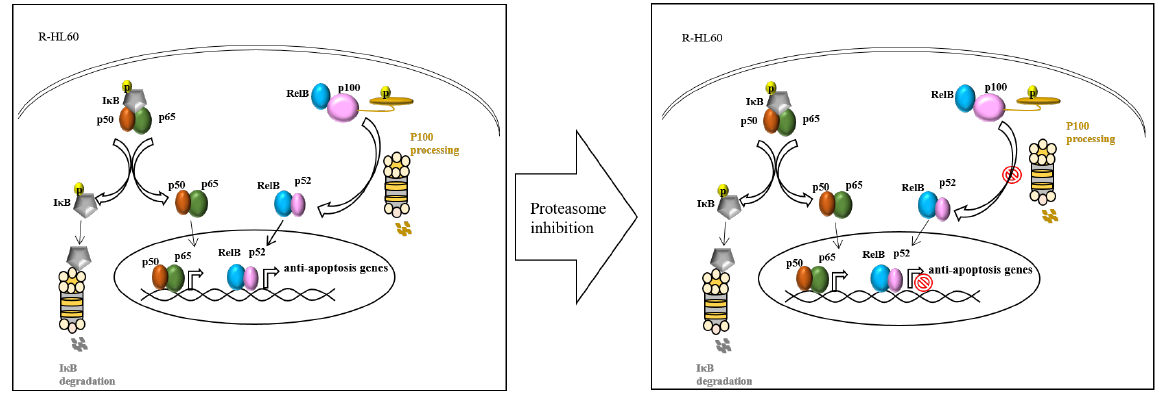
Figure 4. Proteasome inhibitors induce cytotoxicity in R-HL60 cells. The cytotoxic effects of ( A ) bortezomib, ( B ) carfilzomib, ( C ) marizomib, and ( D ) cytarabine combined with each protea- some inhibitor in R-HL60 cells were detected using the CCK-8 assay after proteasome inhibitors treatment for 24 h (cytarabine: 100 µ M; bortezomib: 200 nM; carfilzomib: 200 nM; marizomib: 200 nM). ( E ) The levels of cleaved-PARP1 and cleaved-caspase 3 in R-HL60 cells were detected using Western blotting following proteasome inhibitor treatment for 24 h (200 nM bortezomib, carfilzomib, and marizomib). ( F ) Apoptosis cells were detected using an Apopxin Green Indicator after treatment with proteasome inhibitors for 24 h (200 nM bortezomib, carfilzomib, and marizomib). The left panel in each figure depicts an image captured using an inverted light microscope, and the right panel de- picts a magnified image (400 × ) derived from an inverted light microscope and immunofluorescence signal (FITC channel). The one-way ANOVA was performed to determine the differences between the experimental and control group, and the Newman-Keuls multiple comparison test was applied as a post hoc test. The data are represented as the mean ± standard error of three independent experiments, with * p < 0.05 indicating a statistically significant difference.